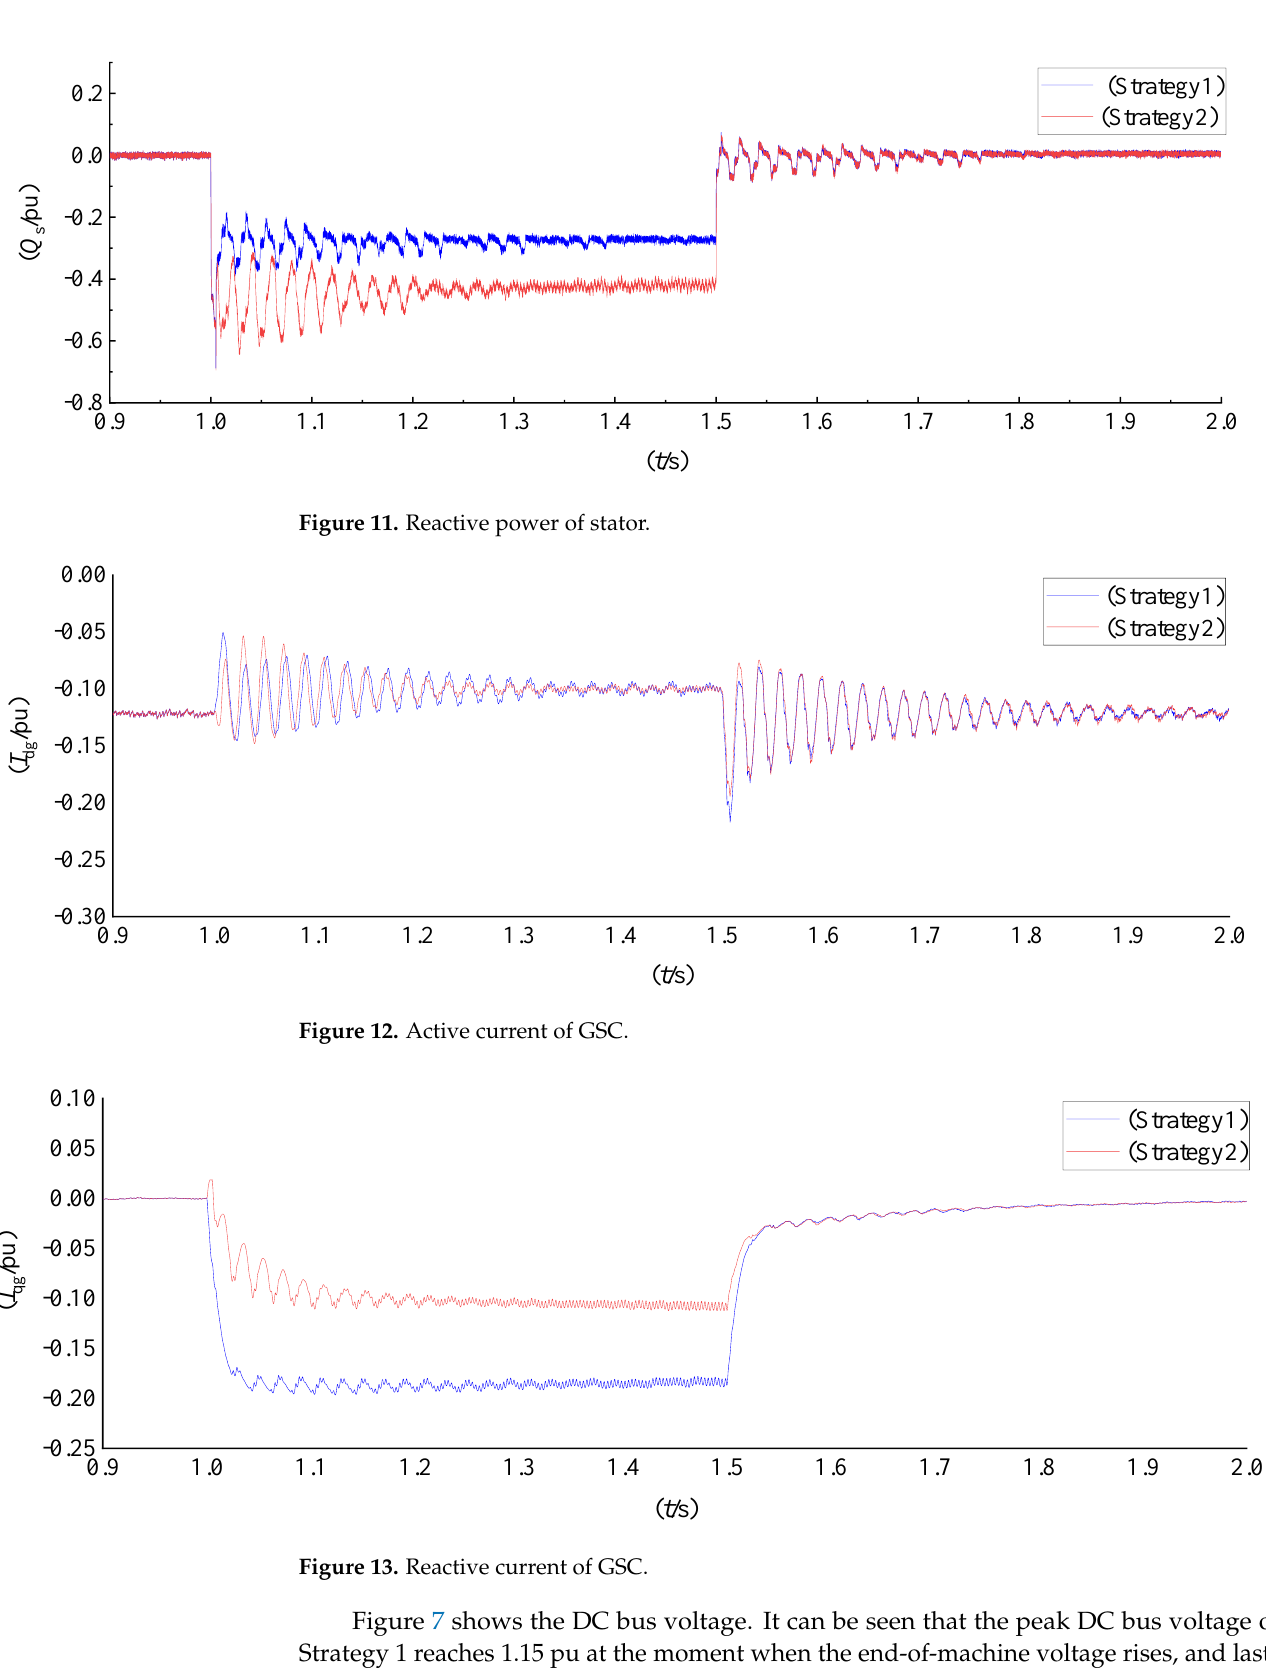
Figure 10. Active power of stator.